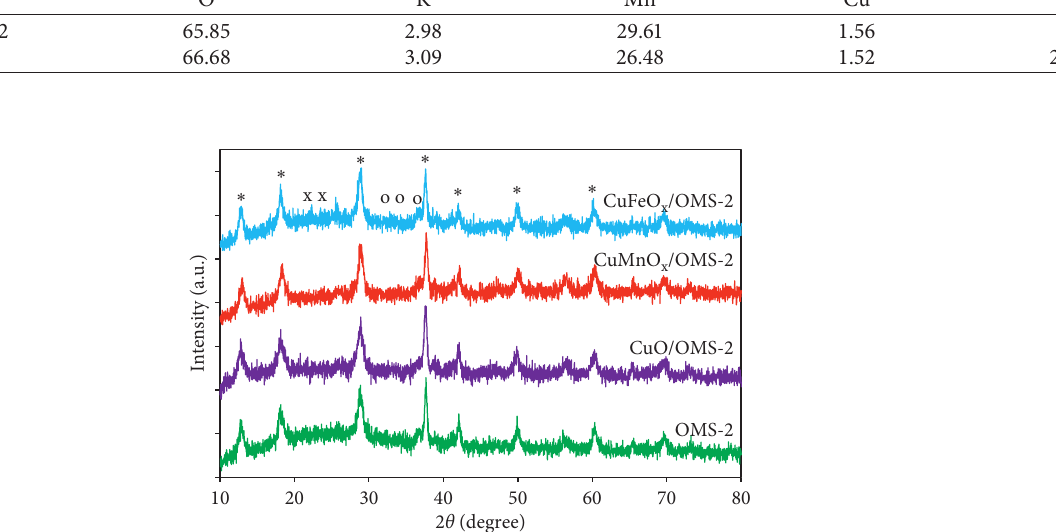
Figure 4: XRD patterns of OMS-2, CuO/OMS-2, CuMnO ferric